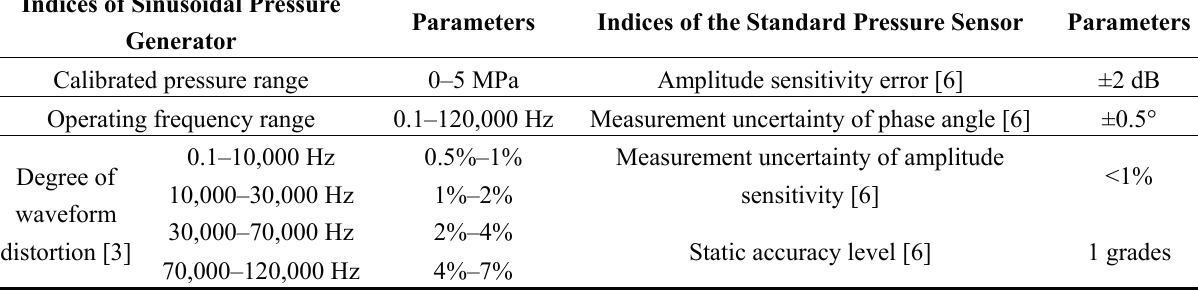
Figure 12. Experimental environment of the frequency-domain experiment. Table 1. Key parameters of the frequency-domain